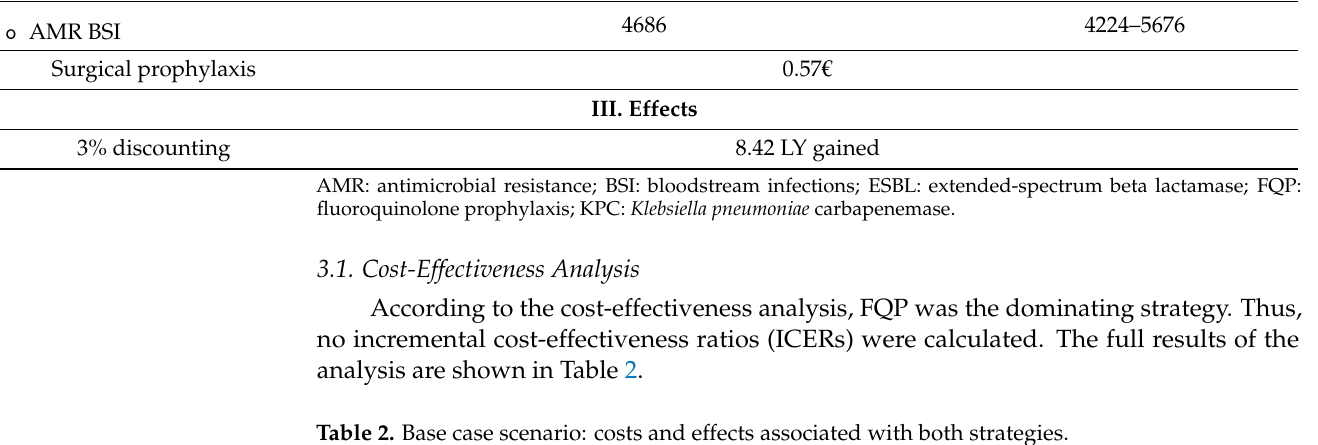
Table 2. Base case scenario: costs and effects associated with both strategies.